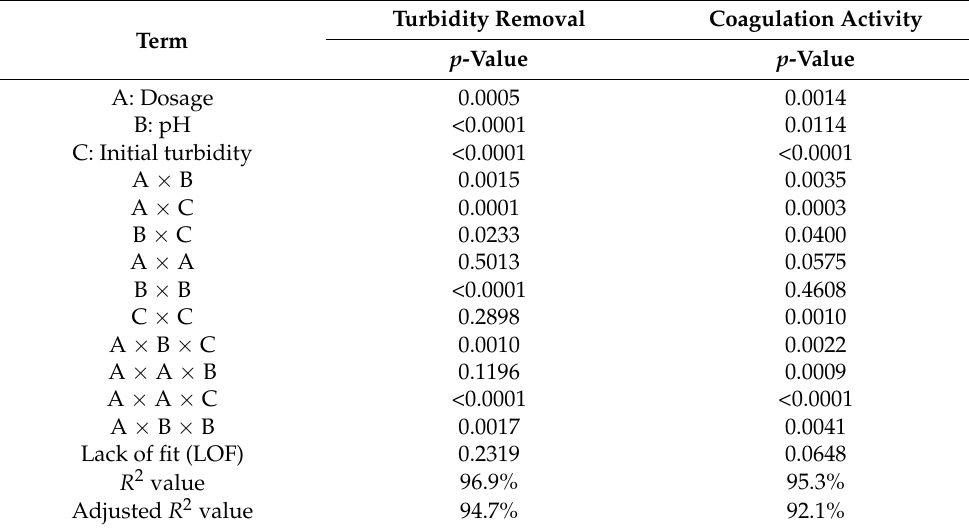
Table 5. Developed adjusted model ANOVA for turbidity removal and coagulation